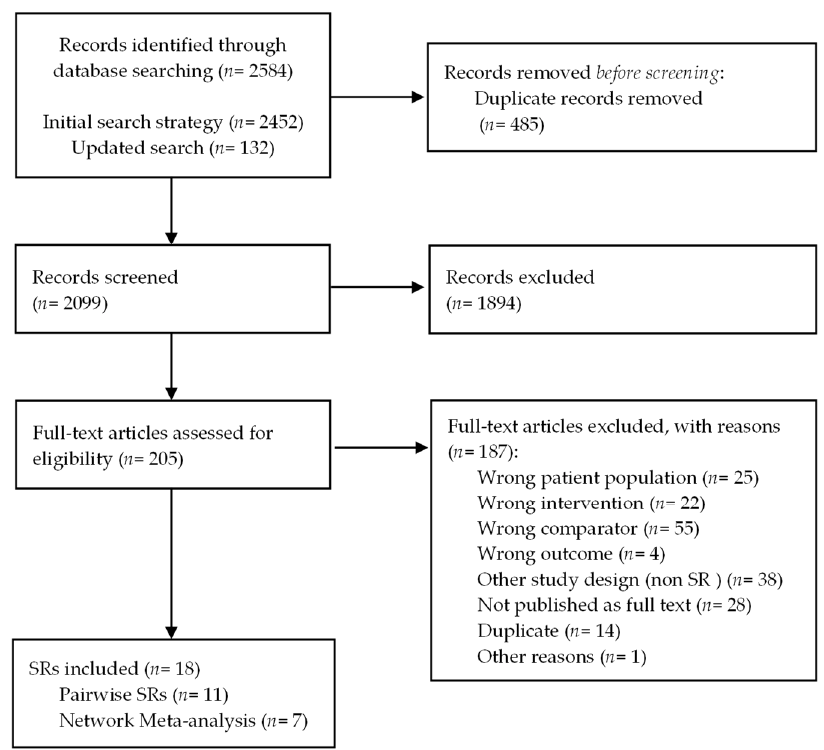
Figure 1. PRISMA flow diagram for the selection of studies.